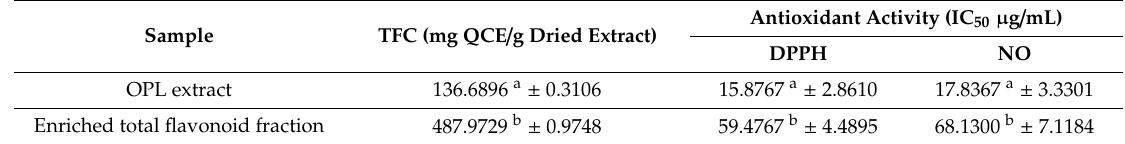
Table 4. TFC and DPPH free radical scavenging activity (IC 50 ) of OPL extract and enriched OPL